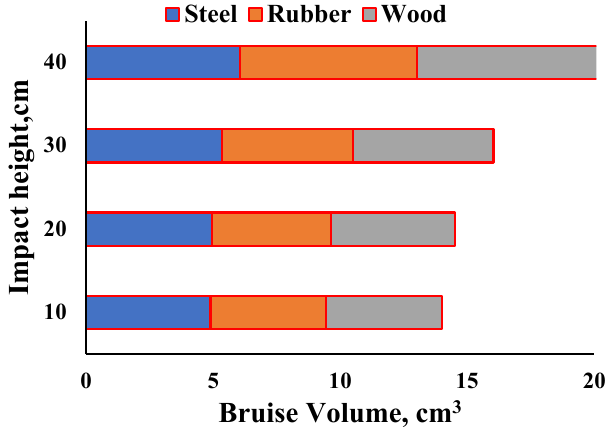
Figure 8. Bruise volume of fruit due to different impact heights at different impacted surfaces.